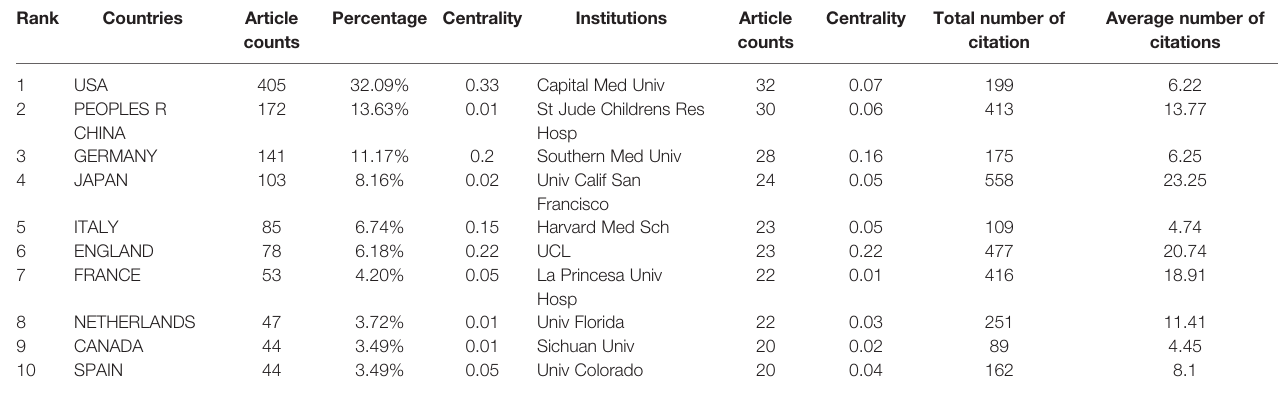
TABLE 1 | The top 10 countries/regions and institutions contributing to publications in craniopharyngioma research.